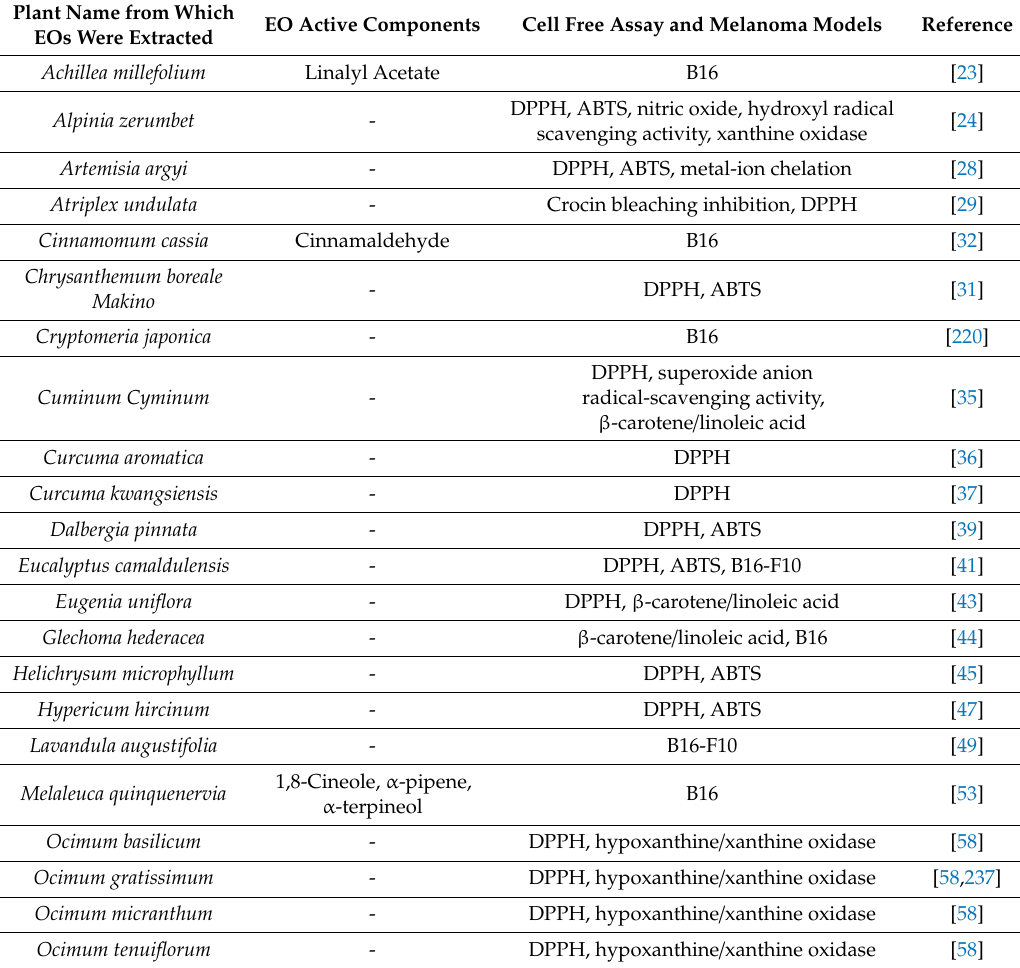
Table 6. EOs and their components showing antioxidant e ff ect in cell-free assay or in melanoma models. Plant Name from Which EOs Were